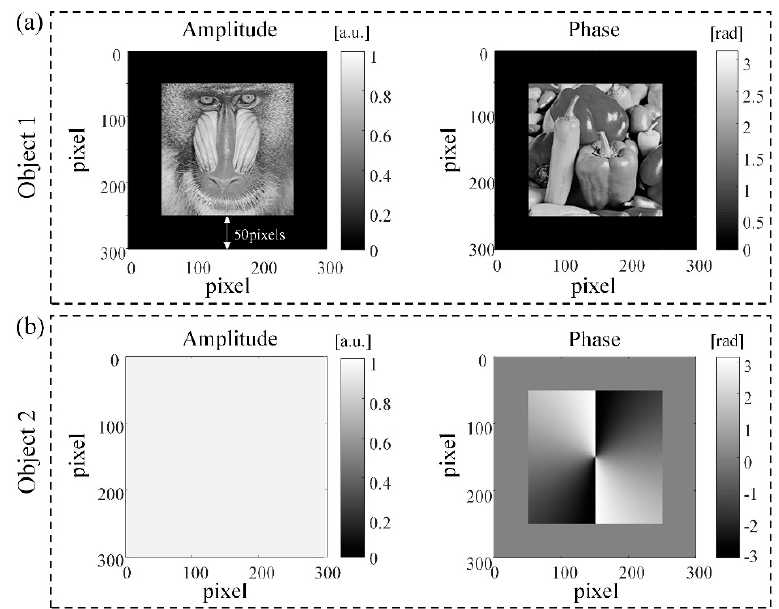
Figure 2. Two test objects: ( a ) rough object and ( b ) smooth object.